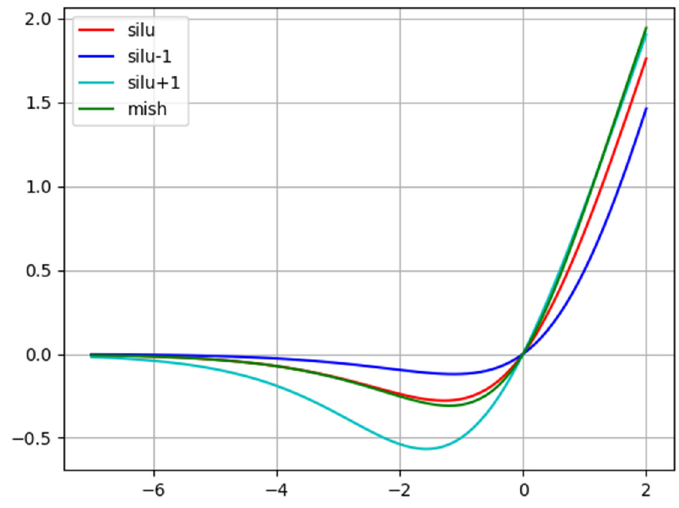
Figure 5. Variation between the perturbed gradient functions.